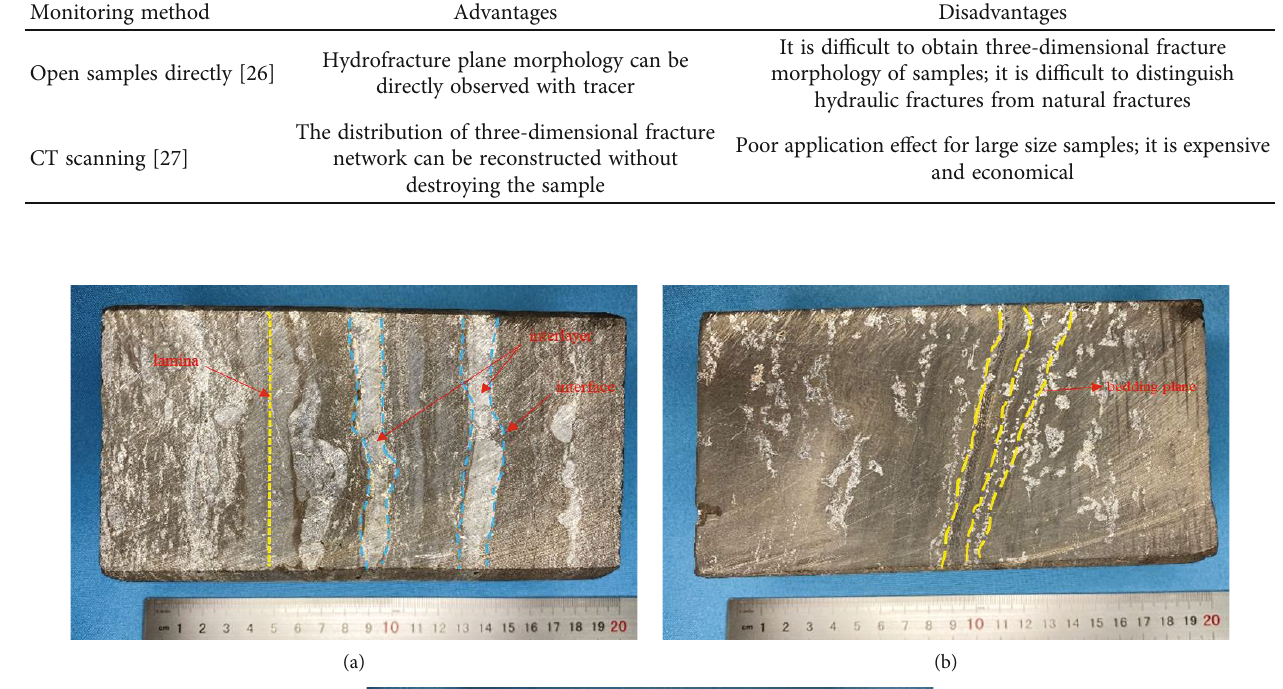
Table 1: Comparison of true triaxial hydraulic fracturing experimental fracture monitoring methods.